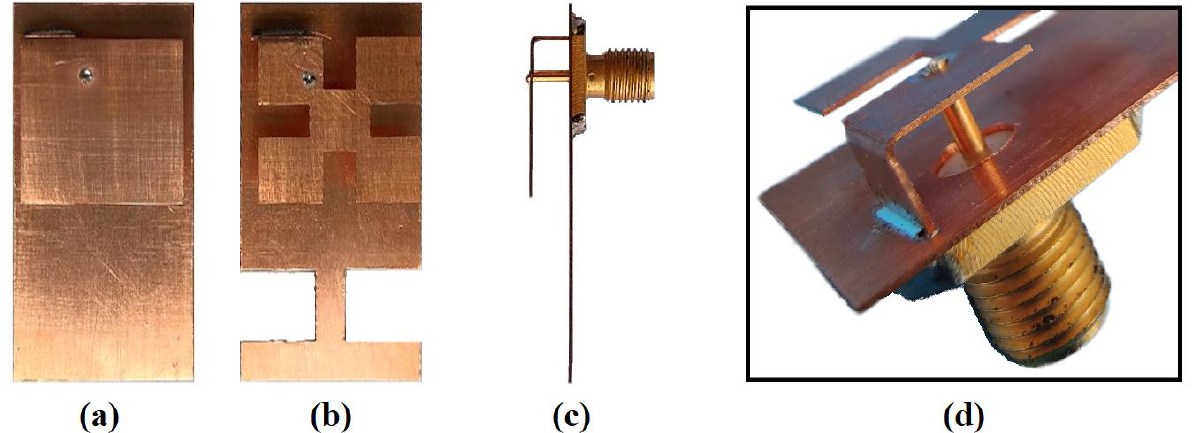
Figure 10. Photograph of the manufactured square ( a ) and Minkowski ( b ) PIFAs along with a side view ( c ) and details of probe feed and shorting plate ( d ).